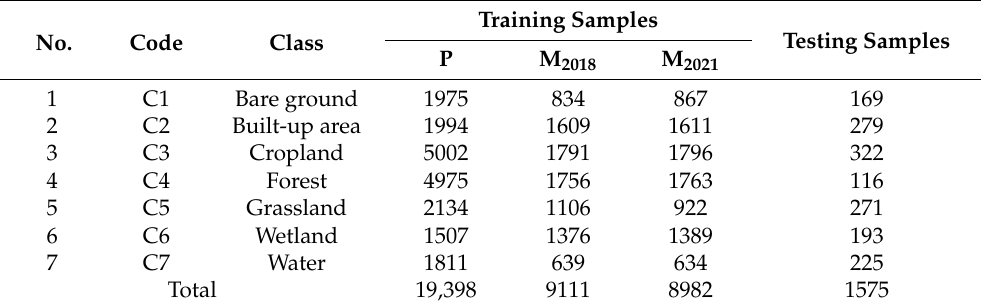
Table 1. Number of samples and description of class system for initial land cover classification in